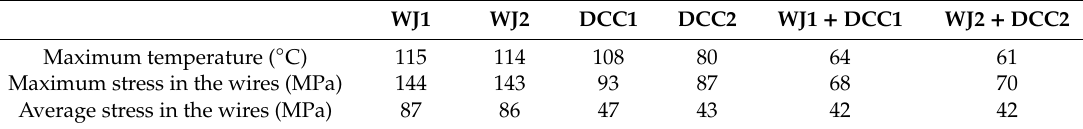
Table 4. Overview of the temperature and stress levels obtained from